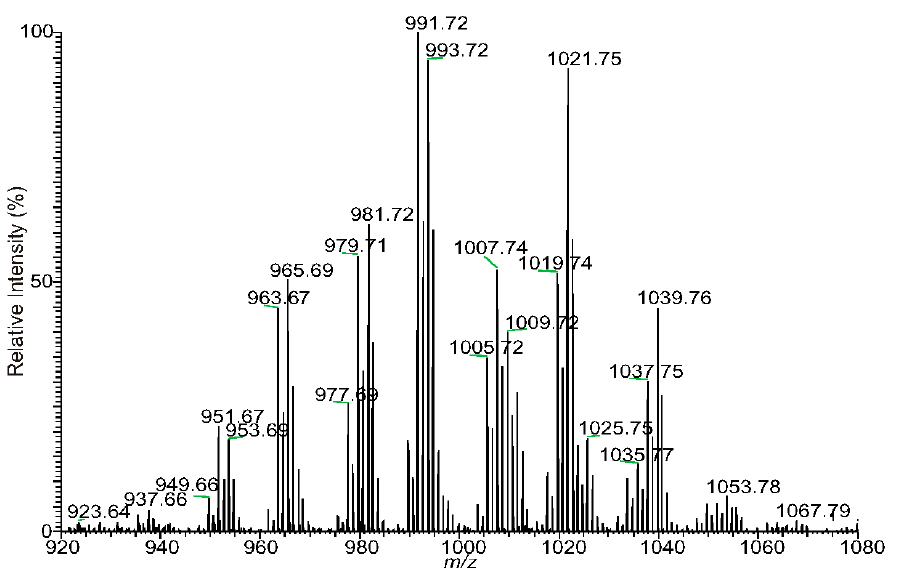
Figure 1. The positive-ion ESI mass spectrum of the [M + Na] + ions of the DAT species isolated from cell envelope of M. tuberculosis . Table 1. The high resolution mass measurements of the [M + Na] + ions of DATs isolated from M. tuberculosis and the assigned structues (* structure not defined).